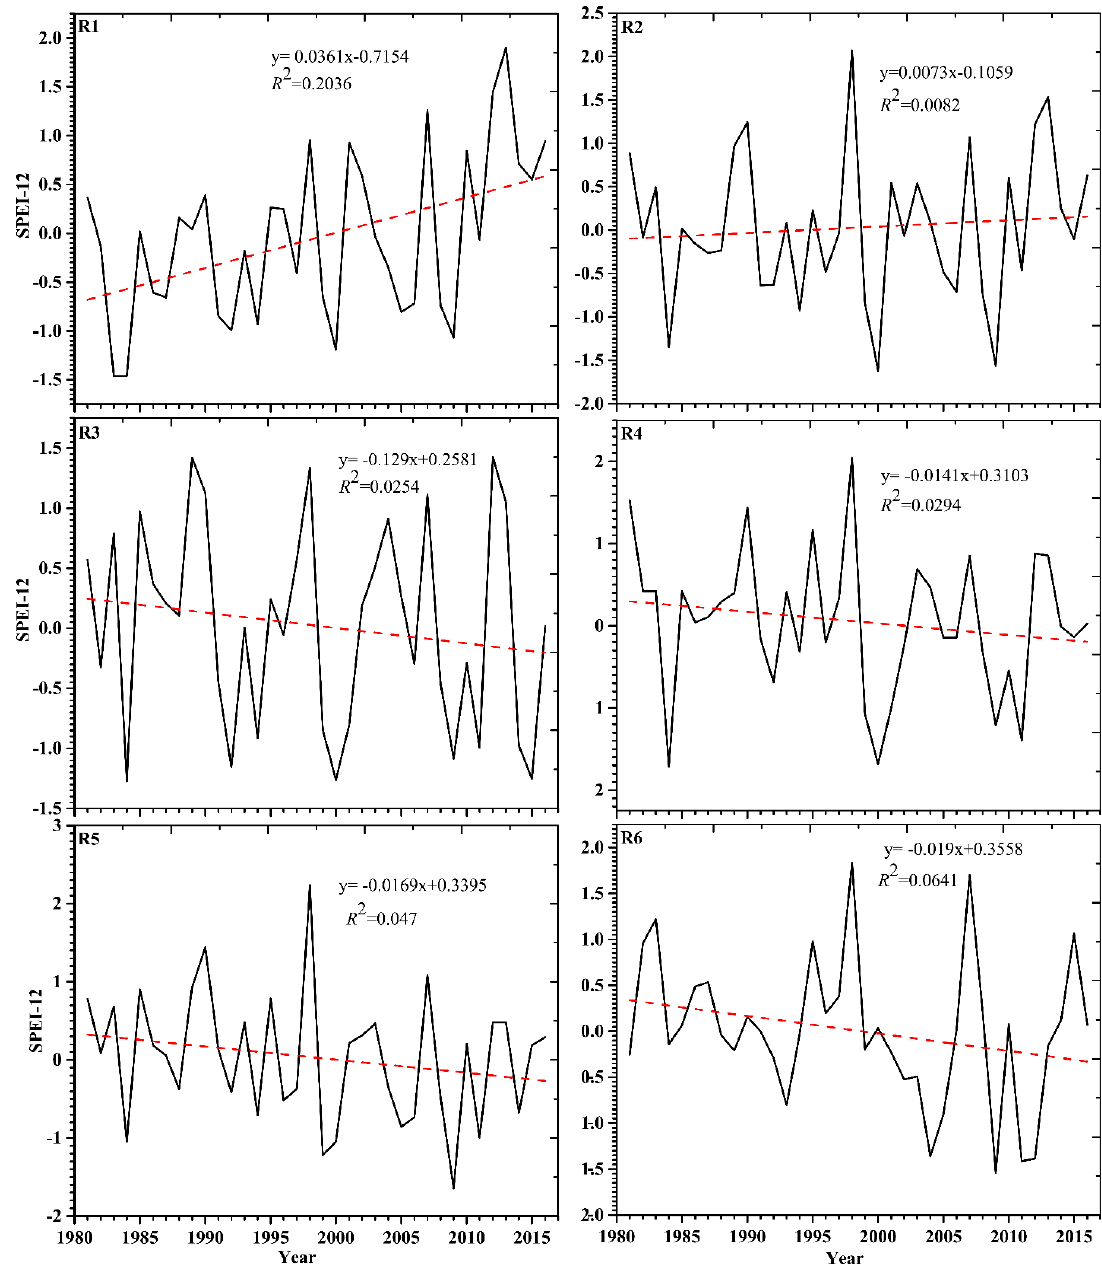
Figure 5. Linear trends of dry and wet events for SPEI-12 over six distinct climatic zones, as presented in Figure 1.